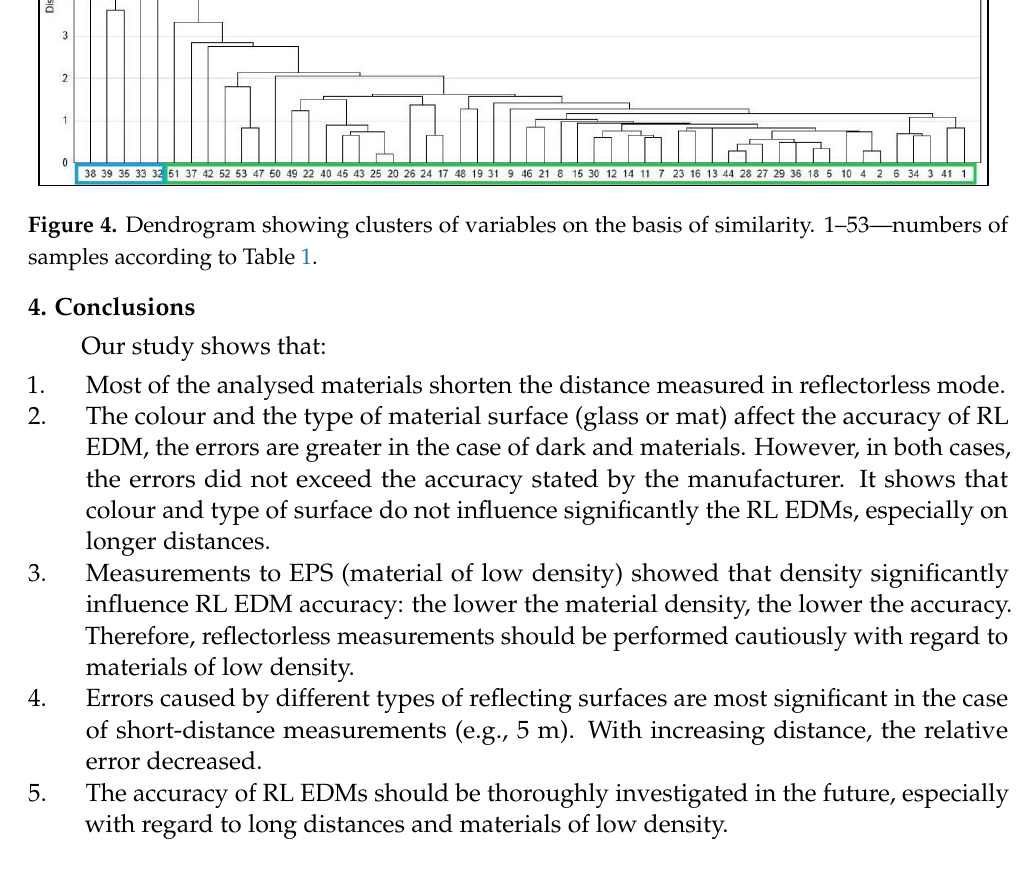
9 of 11 Table 4. Mean values of absolute RL EDM errors on distances: 5, 10 and 20 m to EPS (expanded polystyrene sheets, commonly called Styrofoam; white). Numbers of samples according to Table 1. No.